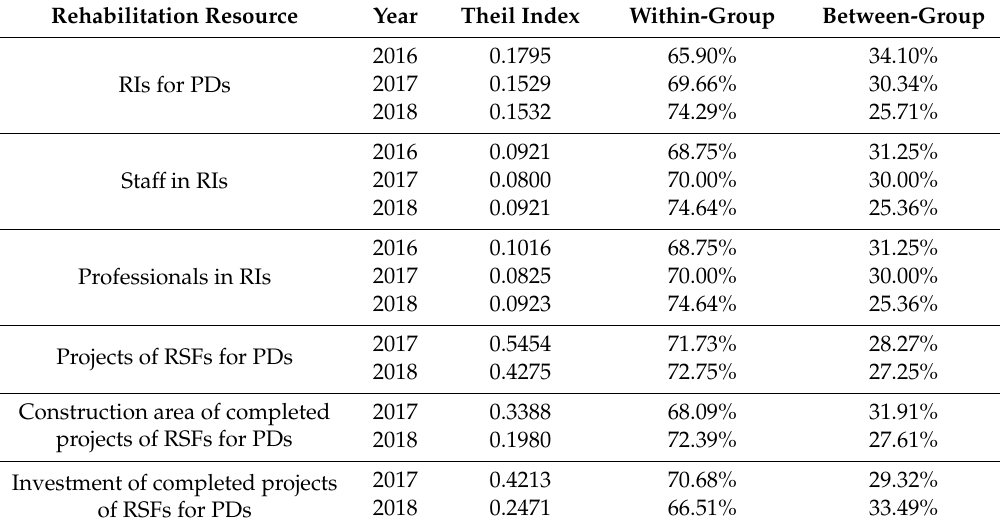
Table 5. Theil Index and contribution rates of rehabilitation resources for PDs in China. Rehabilitation